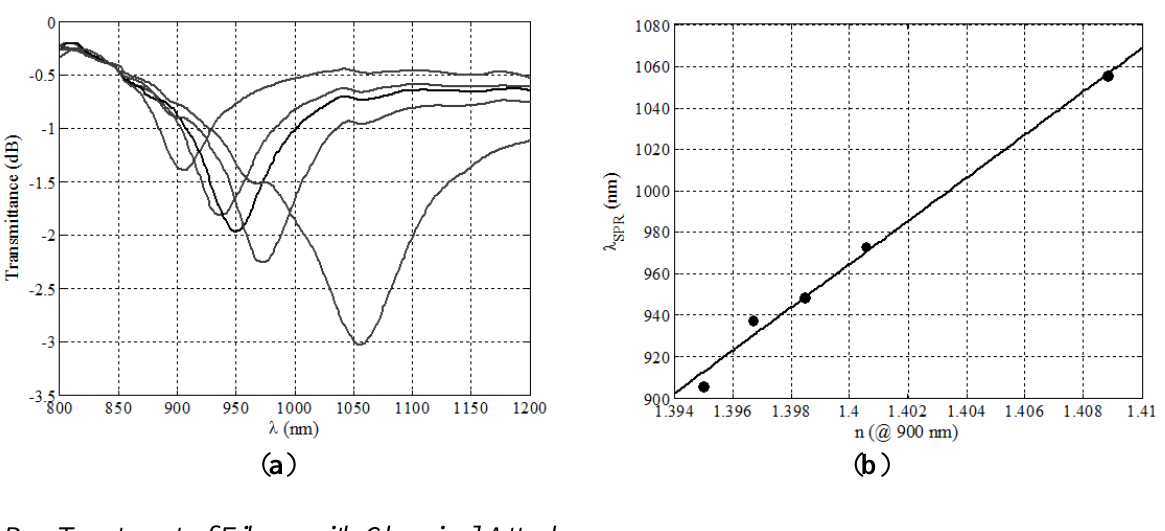
Figure 6. ( a ) Behaviour of a DLUWT with 8 nm of aluminum and 30 nm of indium nitride. Sensitivity, measured from the slope of the curve of figure ( b ) is 10,800 nm/RIU (figures originally published in [12], © 2011, reproduced with permission from